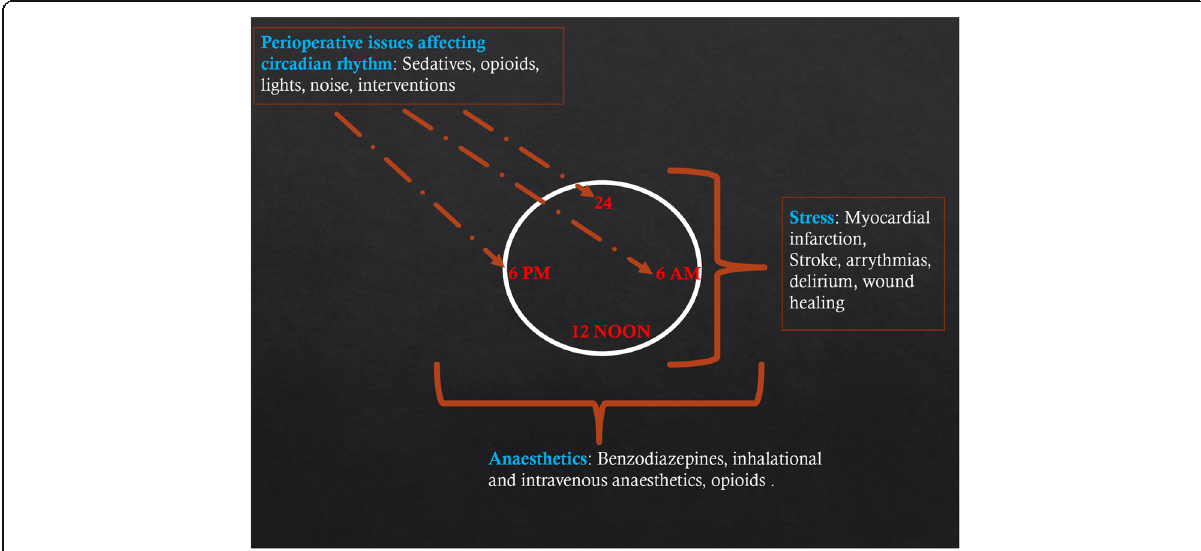
Fig. 2 Diagram showing the relationship of anaesthesia and perioperative factors in affecting the circadian rhythm and its